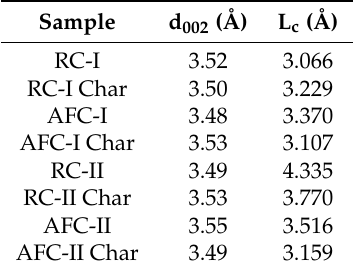
Figure 4. XRD patterns of RCs, AFCs and their Chars (( a ): I, ( b ): II). Table 3. Crystalline structure fitting results of RCs, AFCs and their Chars.